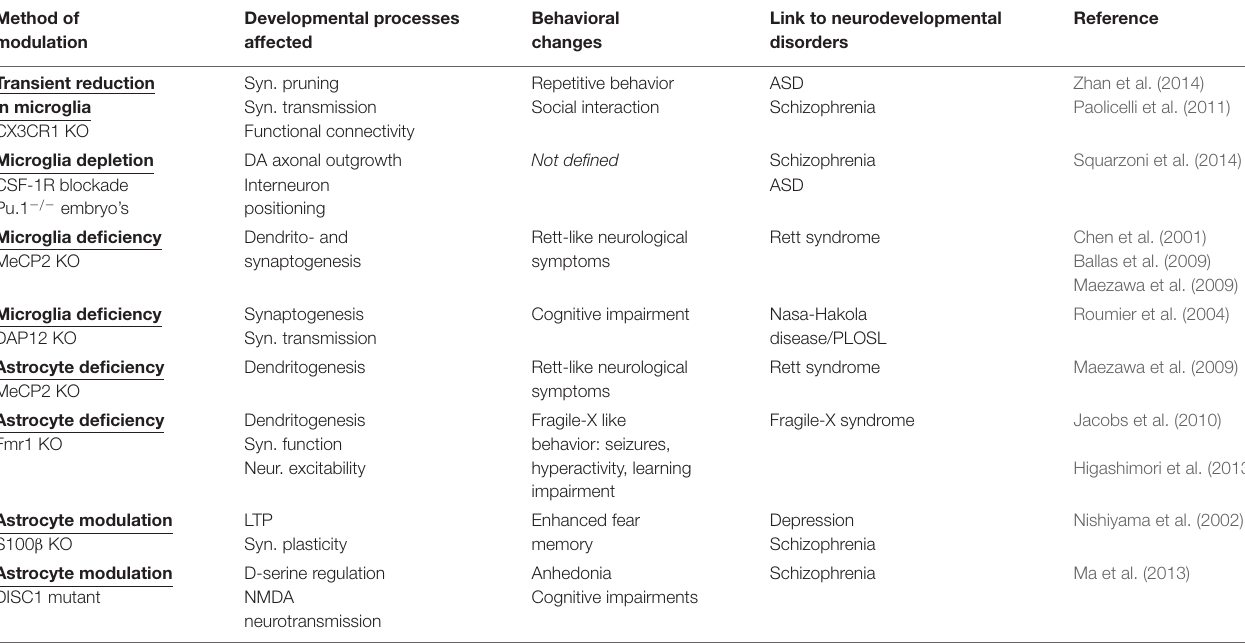
TABLE 1 | Glia dysfunction that affect developmental processes linked to neurodevelopmental